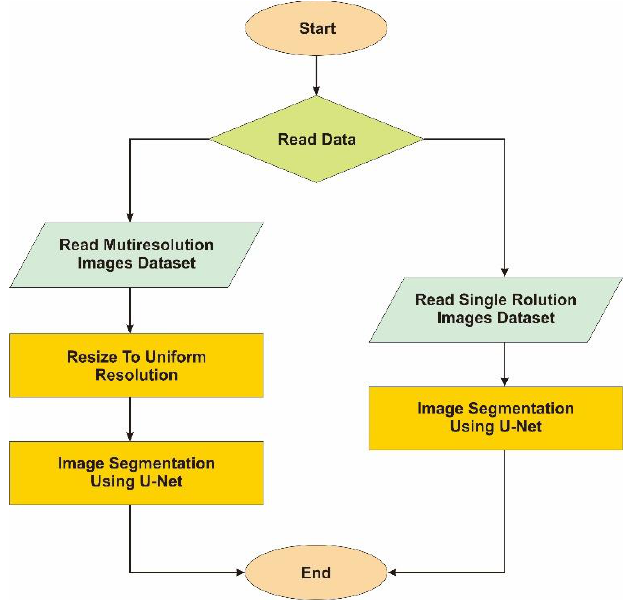
Figure 2. Purposed Research